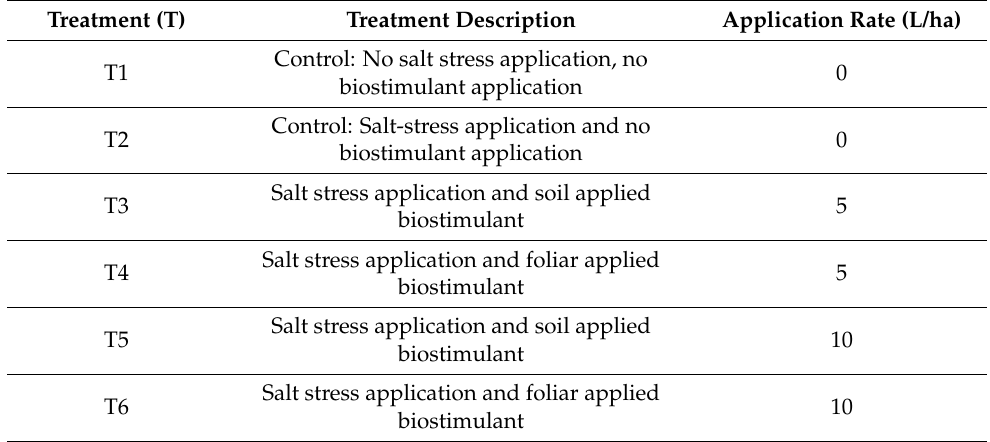
Table 1. Description of treatments and their corresponding Si-based biostimulant application rates. Treatment